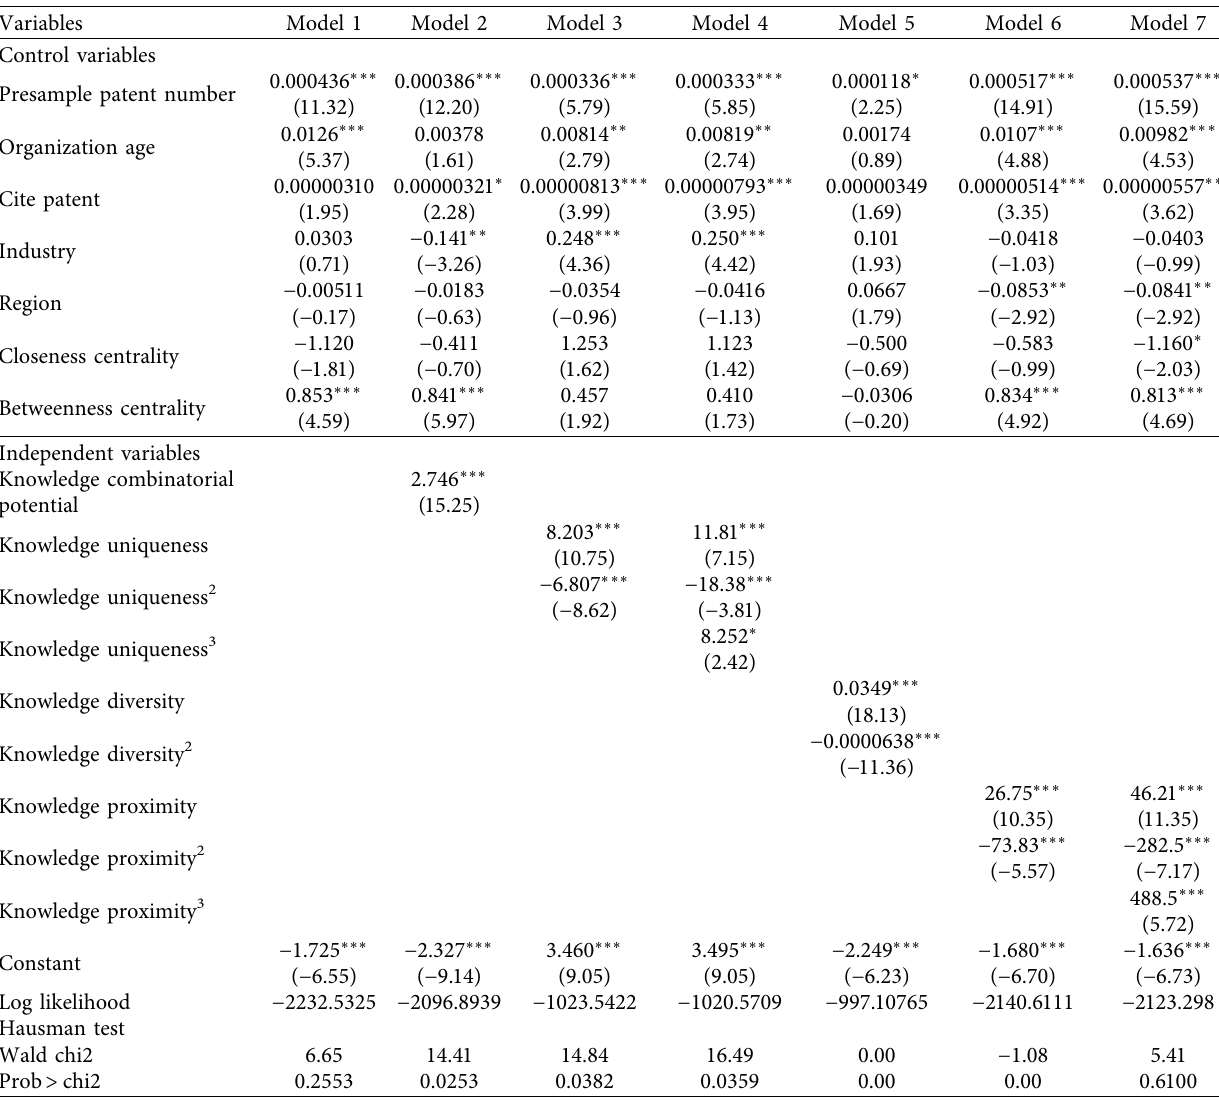
Table 2: Negative binomial analysis of knowledge attributes and organizational innovation